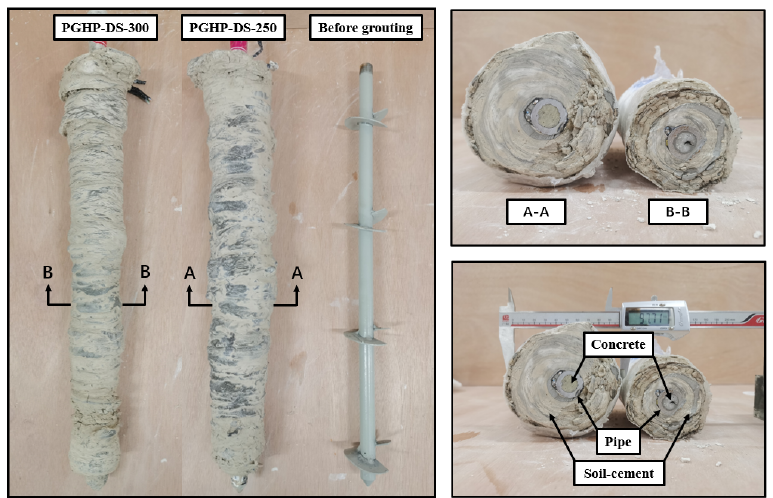
which is similar to the Mansour [17] pile shaft cross section. The soil-cement cross section of PGHP-DS-300 was more sparse compared to that of PGHP-DS-250, which may further prove that too fast of a drilling speed could affect the bond diameter. prove that too fast of a drilling speed could affect the bond diameter.